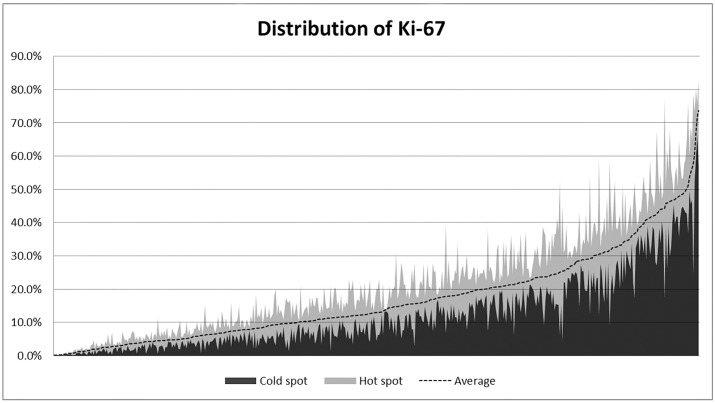
The distribution of Ki-67 labeling indices in 493 luminal breast cancers.The X-axis represents the individual cases, arranged in ascending order based on their Ki-67 labeling index (LI) measured by the average method. The Y-axis represents the individual Ki-67 LIs measured by the hot spot method (the edge of the light gray area) and the average method (dotted line), and the values measured at the “cold spot”, the area with the lowest Ki-67 LI (the edge of the dark gray area). The extent of the light gray colored area represents the difference between the Ki-67 LI measured at the hot spot and the cold spot (Δ Ki-67).